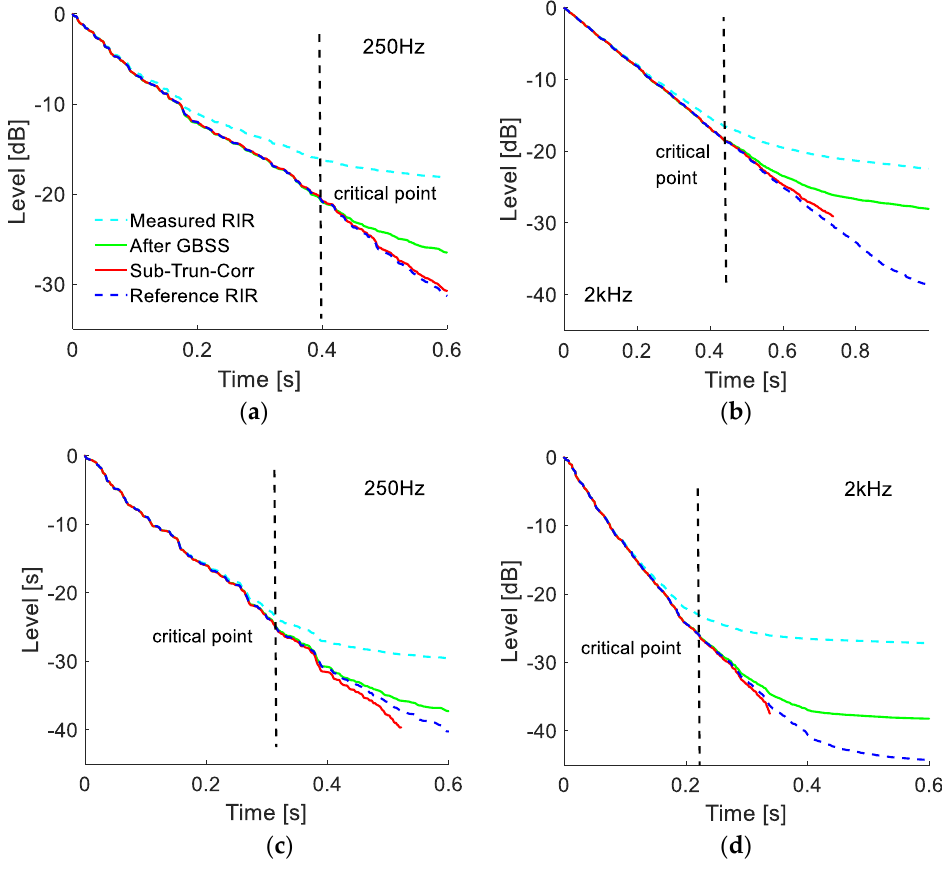
Figure 8. Effects of the GBSS algorithm and compensation method of the measured RIRs filtered in octave bands (250 Hz and 2 kHz): ( a , b ) comparison results for room A; ( c , d ) comparison results for room